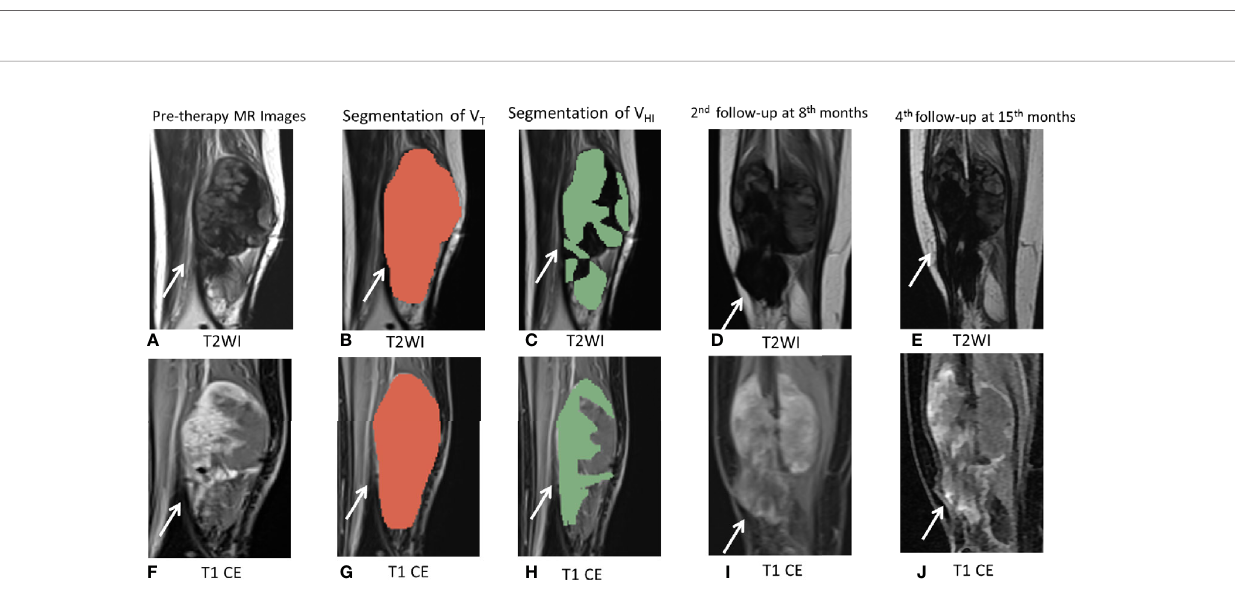
FIGURE 6 | MR images of the representative cases. (A – J) A 26-year-old female patient with DF of right calf muscle with imatinib treatment of (arrows). Pre-therapy MR images refer to examination before imatinib treatment. Pre-therapy (A, F) diameter, 113.0 mm; On T2WI, V T = 162,695 mm 3 , V HI = 97,617 mm 3 , HI = 60% (grade = 2); On T1 CE, V T = 163,750 mm 3 , V HI = 106,438 mm 3 , HI = 65% (grade = 2). Segmentation of V T ( B, G , red zone) and segmentation of V HI ( C, H , green zone). Second follow-up at 8 months since imatinib treatment (D, I) diameter, 112.0 mm indicate a 0.9% decrease in tumor size. The tumor response assessment